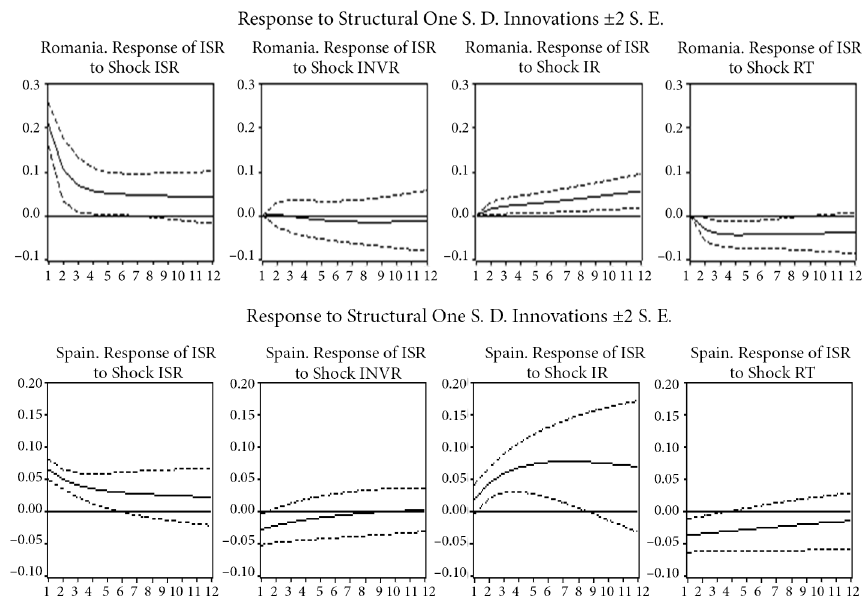
Figure 2. The impulse response functions